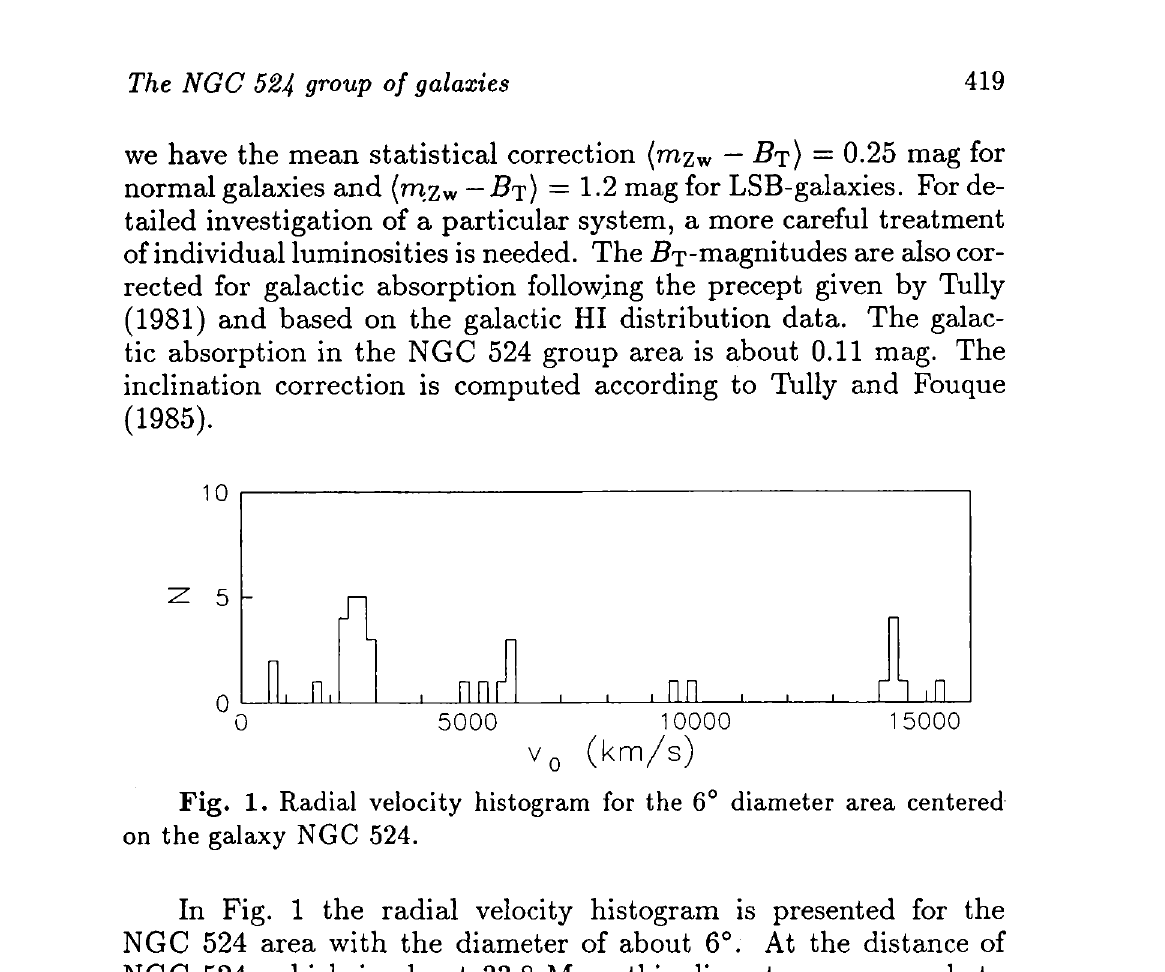
Fig. 1. Radial velocity histogram for the 6° diameter area centered on the galaxy NGC